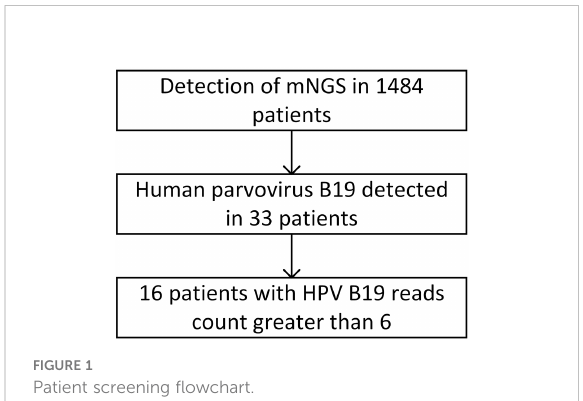
FIGURE 1 Patient screening fl